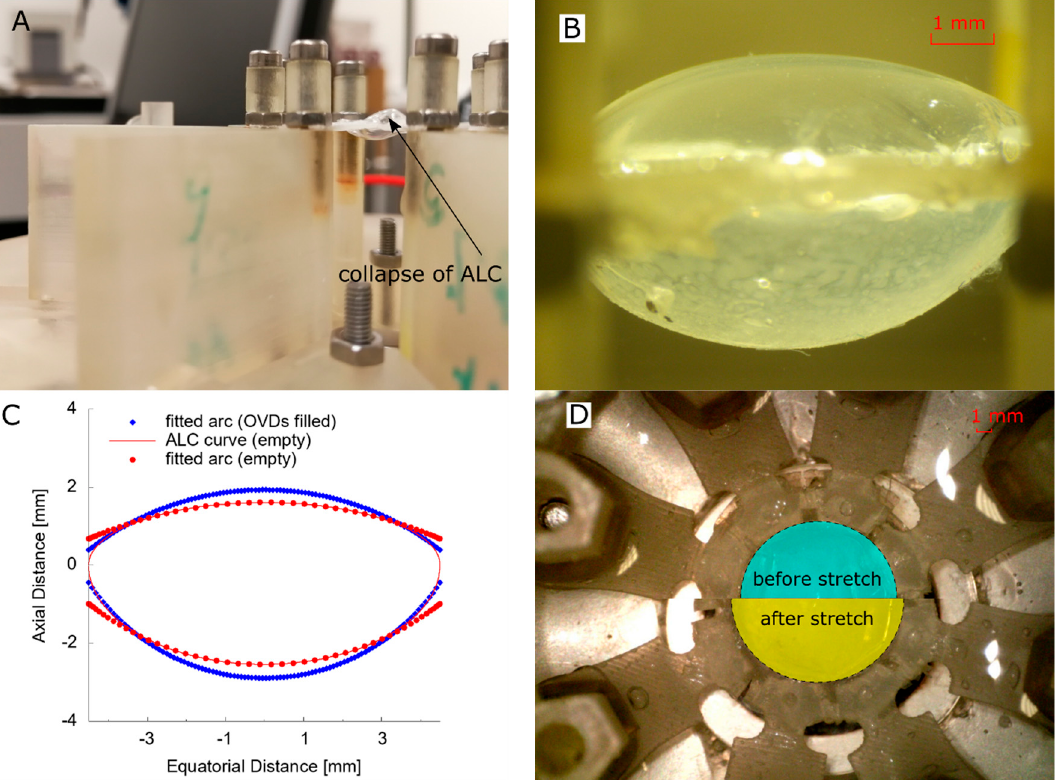
Figure 4. Calibration of LRSS with ALC: ( A ) ALC mounted on LRSS; ( B ) ALC on LRSS filled with OVDs; ( C ) comparison of ALC before and after filling OVDs; ( D ) comparison of lens diameter before and after stretch.